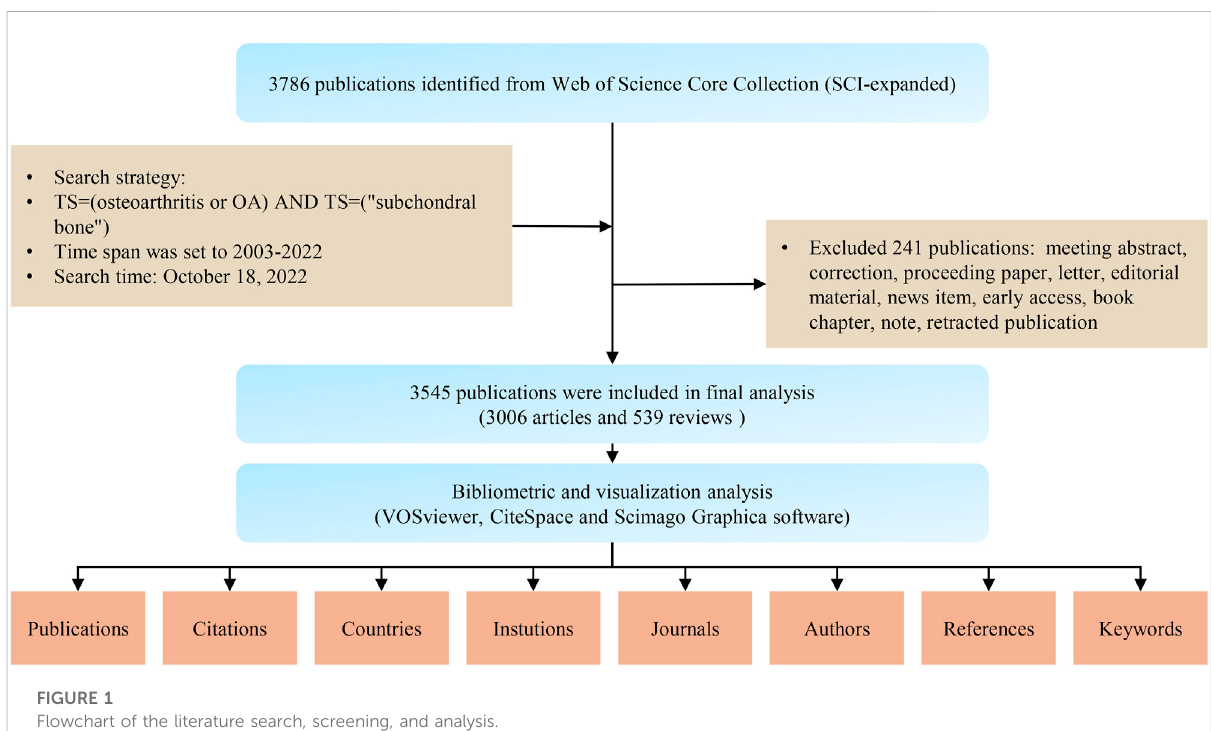
FIGURE 1 Flowchart of the literature search, screening, and